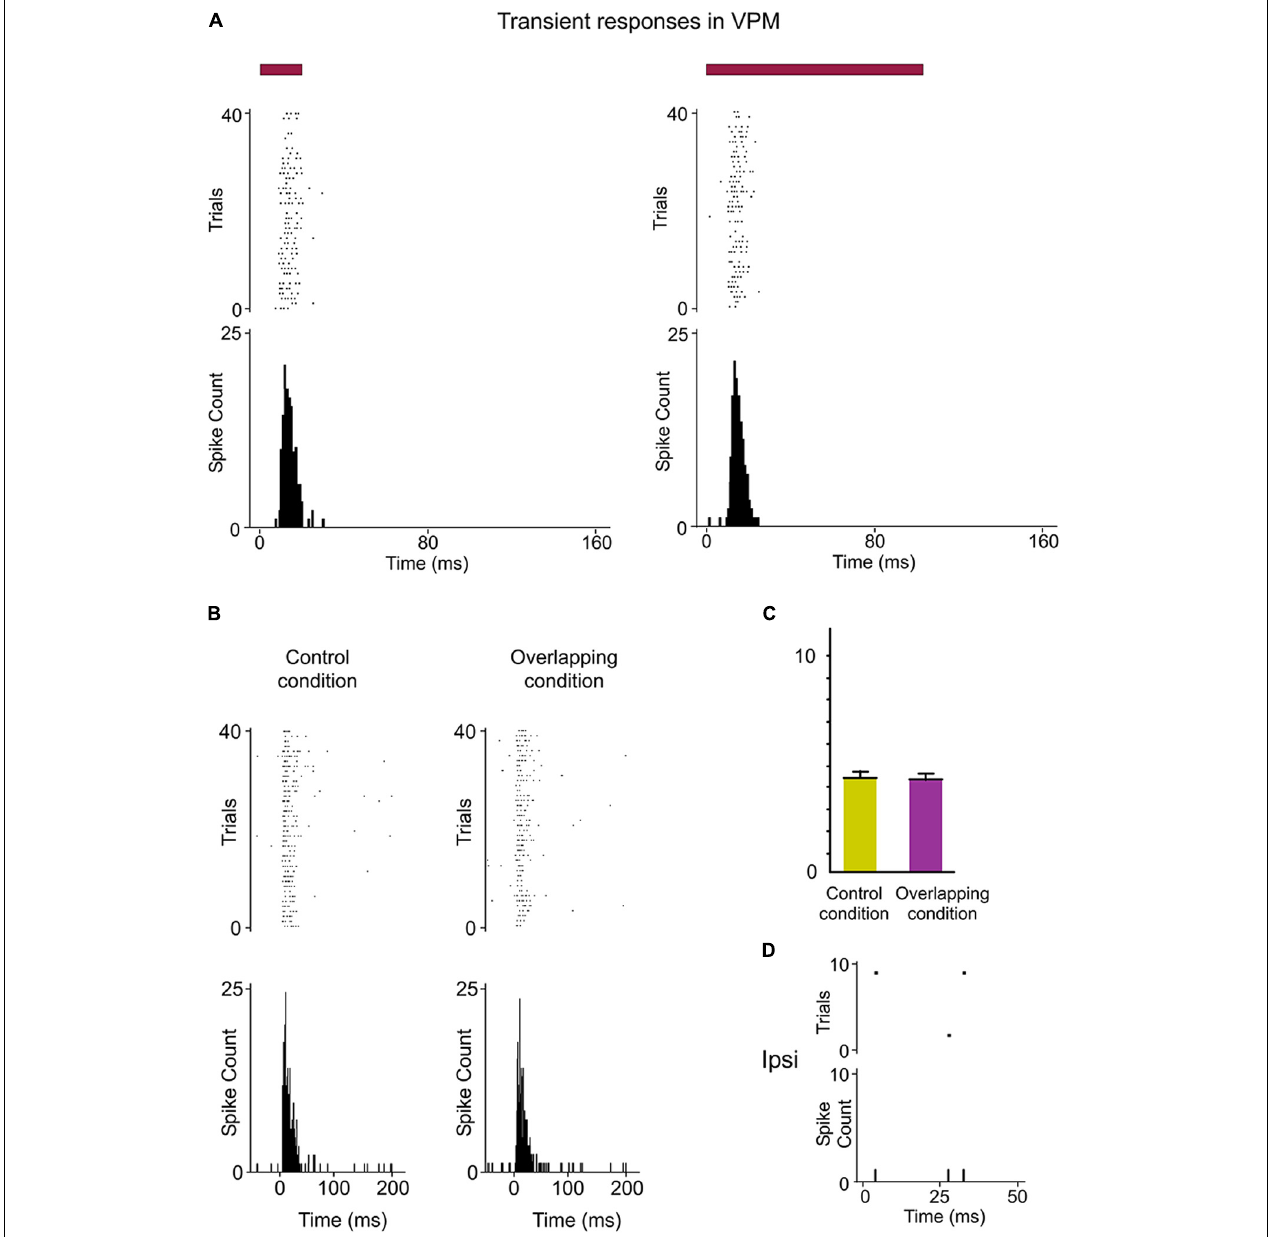
FIGURE 7 | Response modes differed drastically between VPM and POm. (A) VPM responses were not sustained along stimulus presence. They were transient responses just to the onset of stimuli. Raster plots and PSTHs showing multi-unit VPM transient responses evoked by the same stimulus with different durations (20 and 100 ms). Note that VPM responses do not allow the discrimination between them. Red color lines indicate the duration of the stimulus. (B) Raster plots and PSTHs showing that VPM response to simultaneous multiwhisker activation (Overlapping condition) is very similar to individual whisker activation alone (Control condition). (C) The mean response magnitude across multi-units ( n = 96) recorded in VPM did not change by the overlapping of spatial signals ( − 2%, p = 0.17, Wilcoxon matched-pairs test). The mean onset latency of VPM responses was 8.32 ± 0.31 ms (ranged from 6 to 11 ms). (D) VPM did not respond to ipsilateral